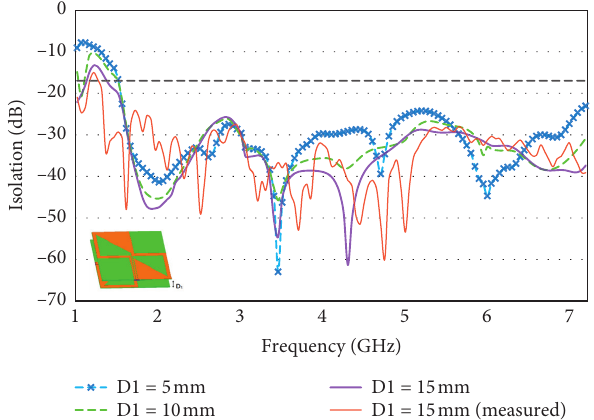
Figure 5: Measured and simulated D1 parameter isolation versus